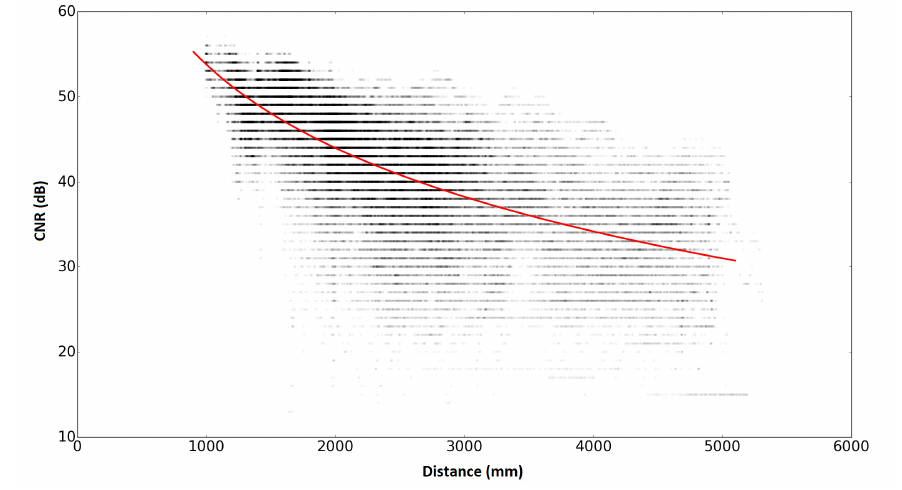
Figure 1. Indoor Messaging System (IMES) radio propagation